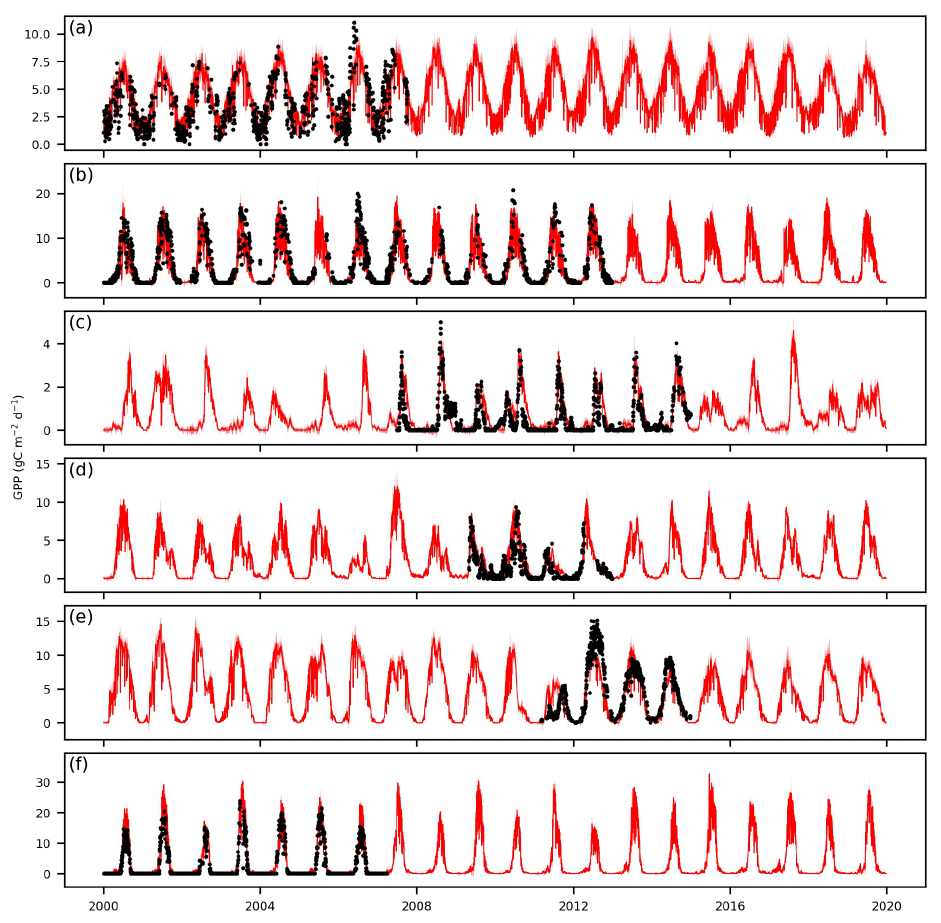
Figure 15. Comparison between AmeriFlux (black dots) and SLOPE (red curves) daily GPP at six AmeriFlux sites (Table S3) from 2000 to 2019. (a) US-Blo (evergreen needleleaf forest, ENF). (b) US-Ha1 (deciduous broadleaf forest, DBF). (c) US-Whs (open shrubland, OSH). (d) US-AR1 (grassland, GRA). (e) US-Myb (wetland, WET). (f) US-Bo1 (cropland, CRO). Shaded areas indicate uncertainties of SLOPE